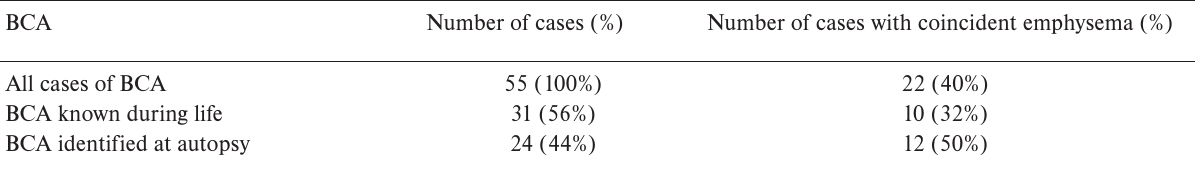
Table 1. Lung cancer diagnosed during life and at autopsy and its association with pulmonary emphysema.